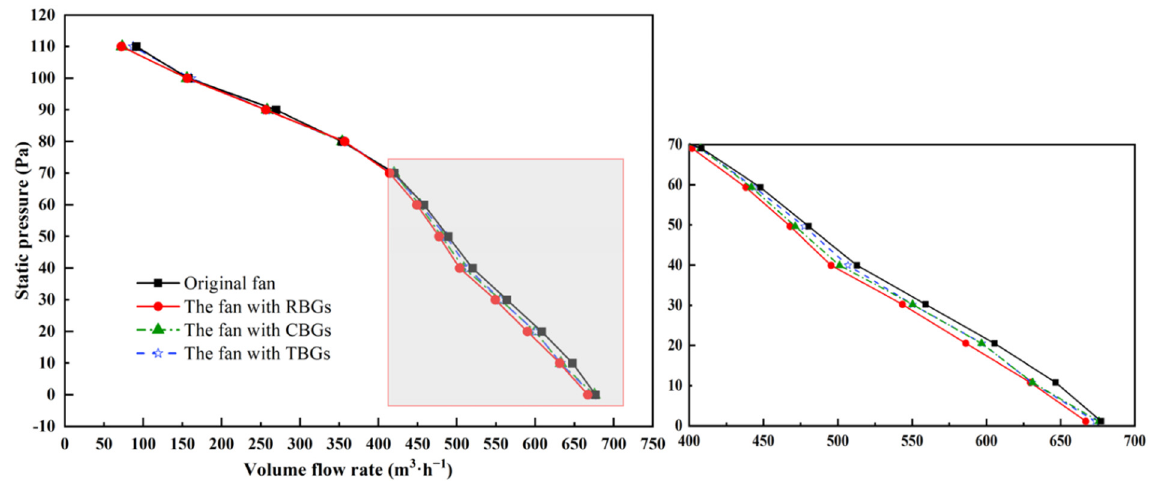
Figure 12. Comparison of P–Q curve between original fan and those with bionic